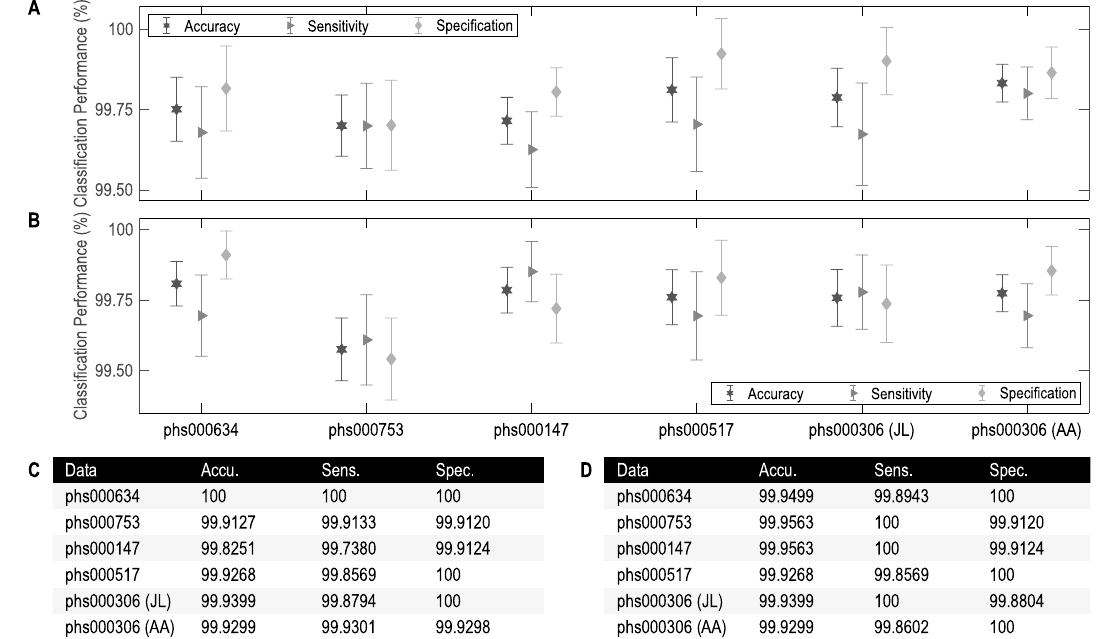
Figure 3. Classification performance of NBCs over the six datasets from five dbGaP studies. ( A ) Accuracy, sensitivity and specification of NBC (1) 634 , NBC (1) 753 , NBC (1) 147 , NBC (1) 517 , NBC (1) 306 - JL and NBC (1) 306 - AA according to 10 fold cross-validation, where the error bars are in form of “mean±std” computed by repeatedly performing 10-fold cross-validation for 100 times. ( B ) Performance of NBC (2) 634 , NBC (2) 753 , NBC (2) 147 , NBC (2) 517 , NBC (2) 306 - JL and NBC (2) 306 - AA according to 10-fold cross-validation. ( C ) Accuracy (accu.; %), sensitivity (sens.; %) and specification (spec.; %) of each NBC (1) study according to leave-one-out. ( D ) Performance of each NBC (2) study according to leave-one-out.